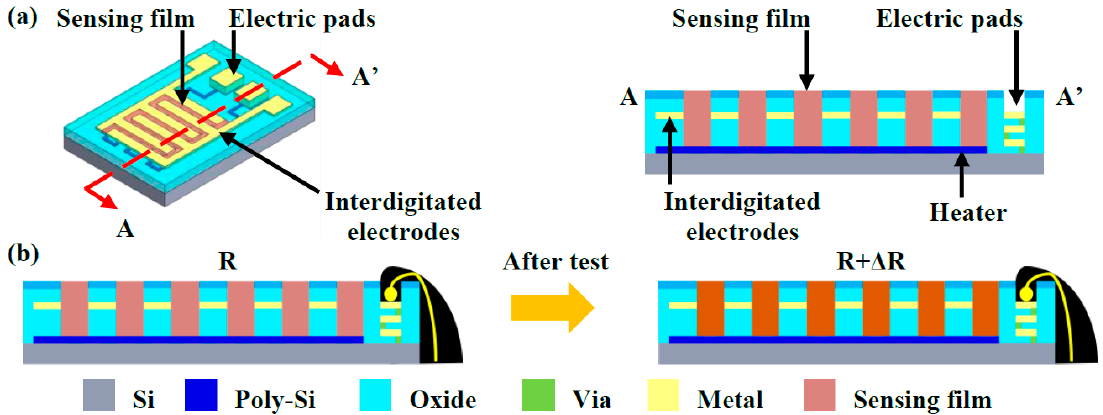
Figure 1. ( a ) The design concept of the gas-sensor, and ( b ) working principle of the gas sensor.